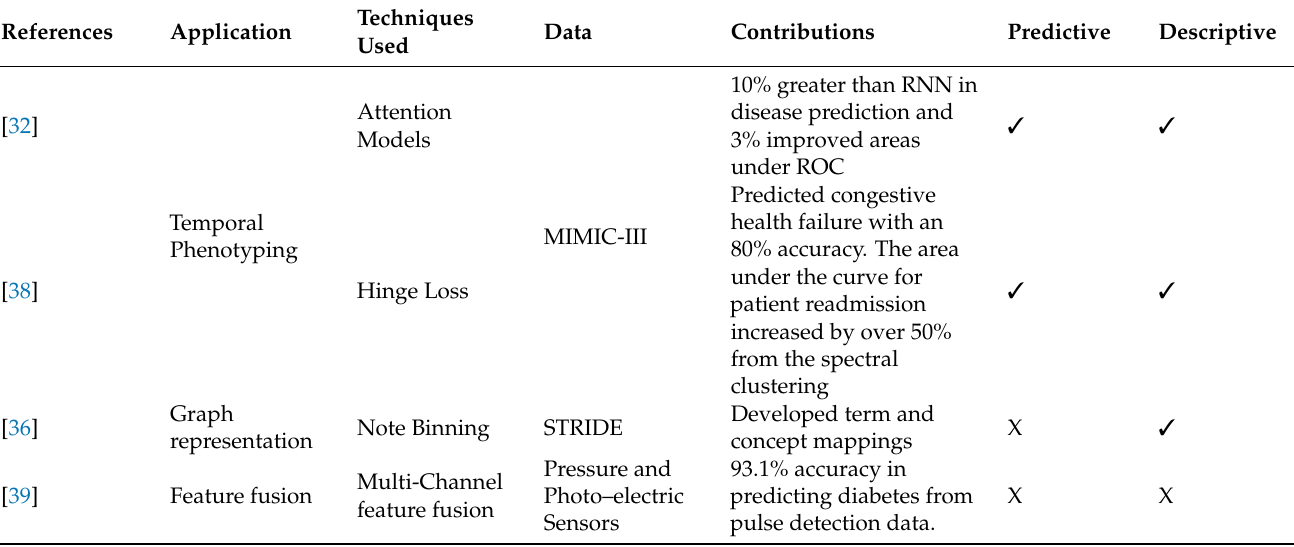
Table 3. Comparison of graph-based